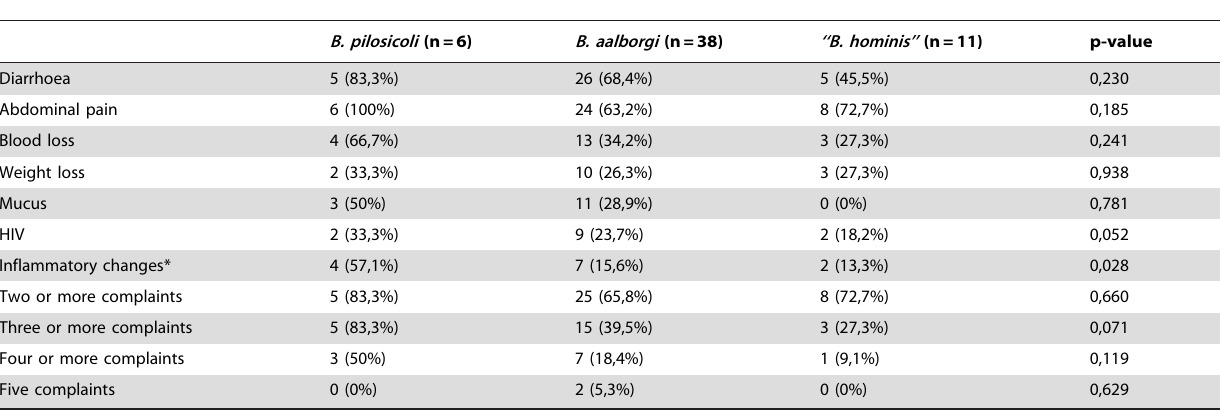
Table 3. Statistical Analyses of Clinical Data #